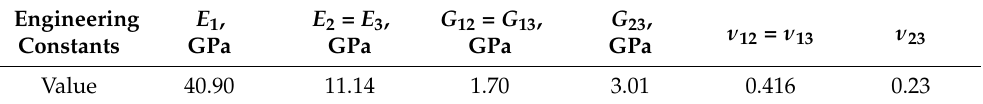
Table 1. The identi fi ed engineering constants. Table 1. The identified engineering